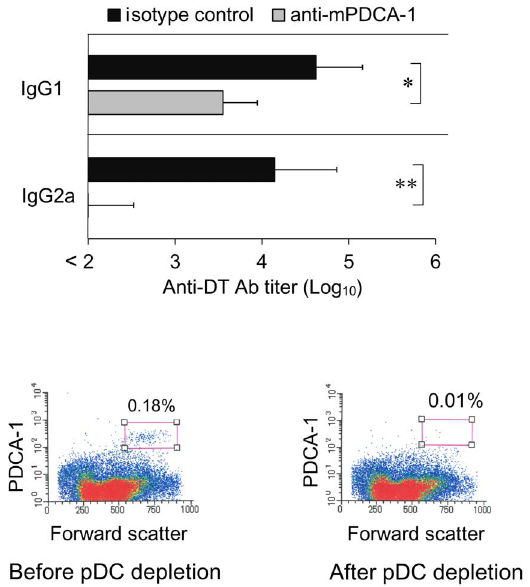
Figure 5. G9.1-induced T H 1-type Ab production was complete- ly pDC-dependent. Anti-mPDCA-1-treated and isotype control- treated BALB/c mice (n=4) were administered DT (2 Lf) plus G9.1 (20 m g) nasally twice at a 1-month interval. Serum titers of anti-DT IgG1 and IgG2a were measured as described in Fig. 3. The percentage of pDCs in splenocytes decreased from 0.18 to 0.01 after anti-mPDCA-1 treatment (lower panel). The pDC-depleted mice exhibited no G9.1- induced IgG2a production (upper panel). * p , 0.05 and ** p , 0.01 as determined by t -test. Three independent experiments yielded nearly identical